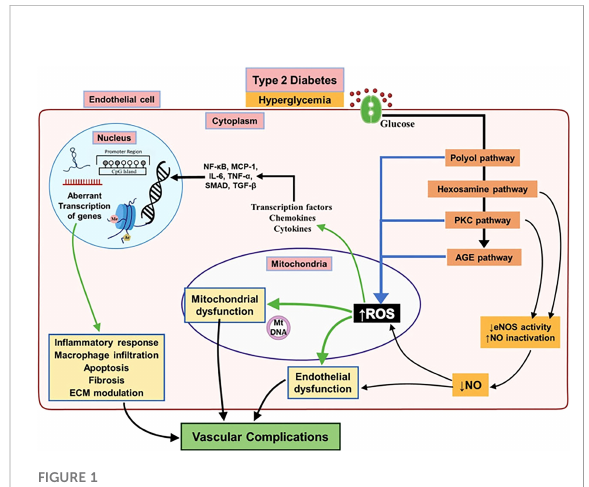
FIGURE 1 Major biochemical and cellular pathways underlying endothelial dysfunction leading to vascular complications associated with T2DM. Chronic hyperglycemia activates different pathways involved in leading to endothelial dysfunction in T2DM subjects result in decreased activity of eNOS and increased mitochondrial ROS overproduction. This will bring up a pro-in fl ammatory environment by activation of several mediators which alter the endothelial epigenome and followed by aberrant transcription of genes regulating in fl ammatory response, macrophage in fi ltration, apoptosis and fi brosis resulting in diabetic vascular complications. Reproduced with permission from Elsevier. Following original report was credited: Dhawan et al.